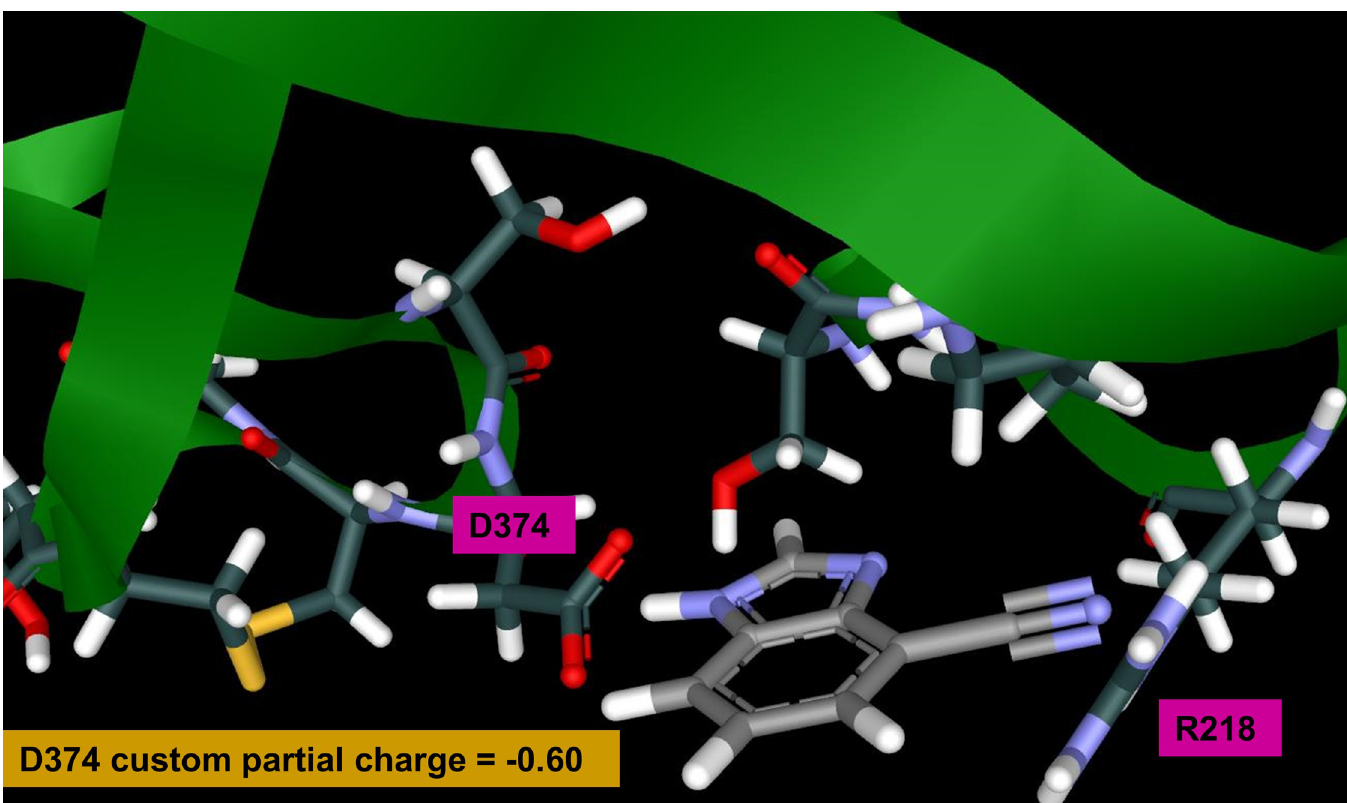
Fig 8. Cyano-benzimidazole is predicted to bind with the highest affinity (lowest chemical potential) at D374 of PCSK9. The GAMESS/RESP calculations on this configuration show that the sum of partial charges on D374 is reduced by 40%.